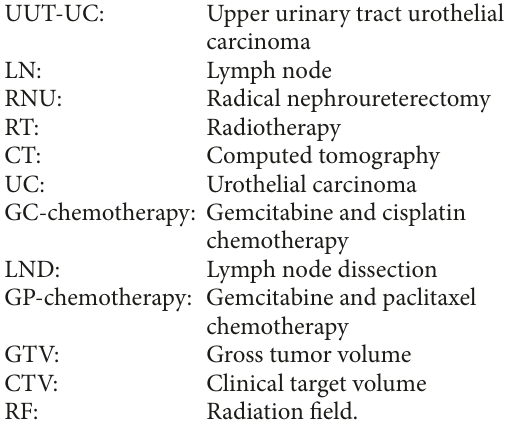
Supplementary 3. Table S1: lymph nodes of clinical course of the